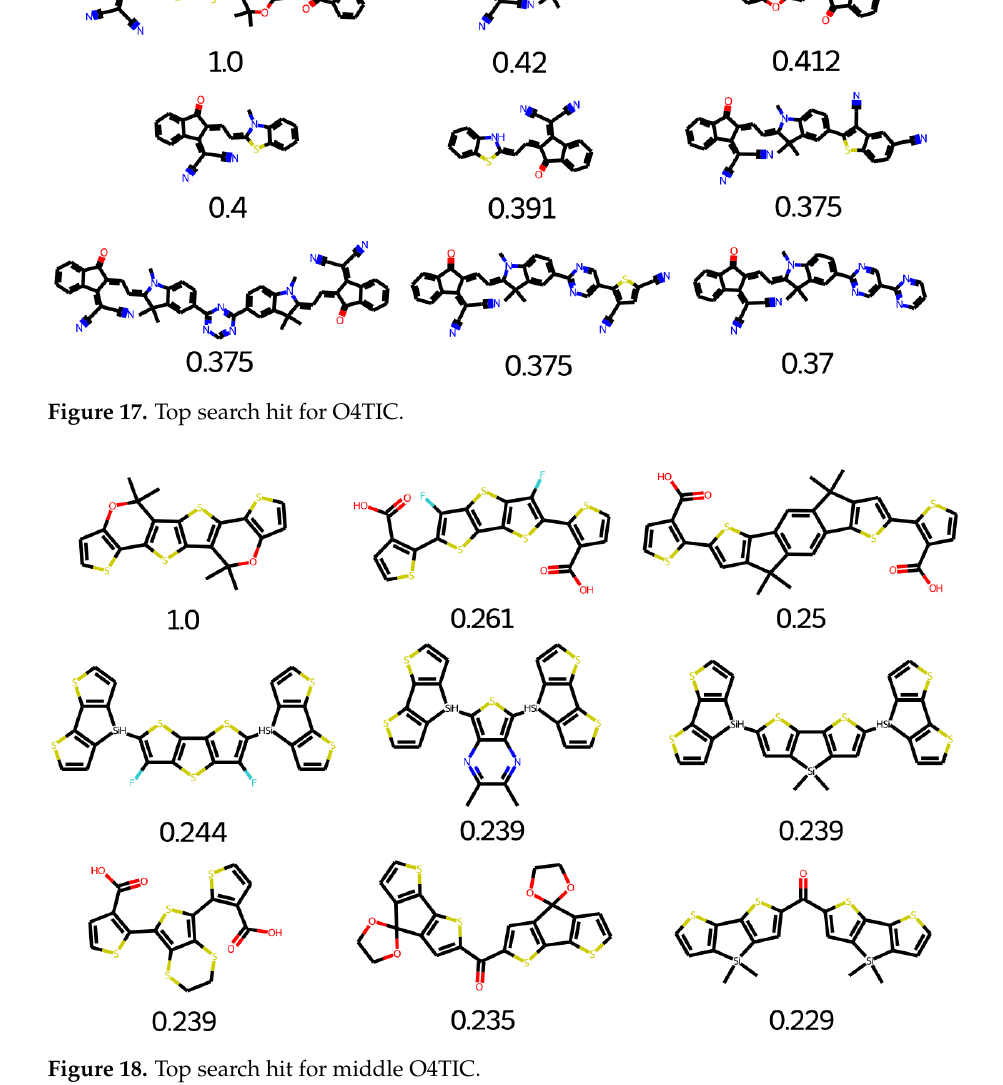
Figure 18. Top search hit for middle O4TIC.